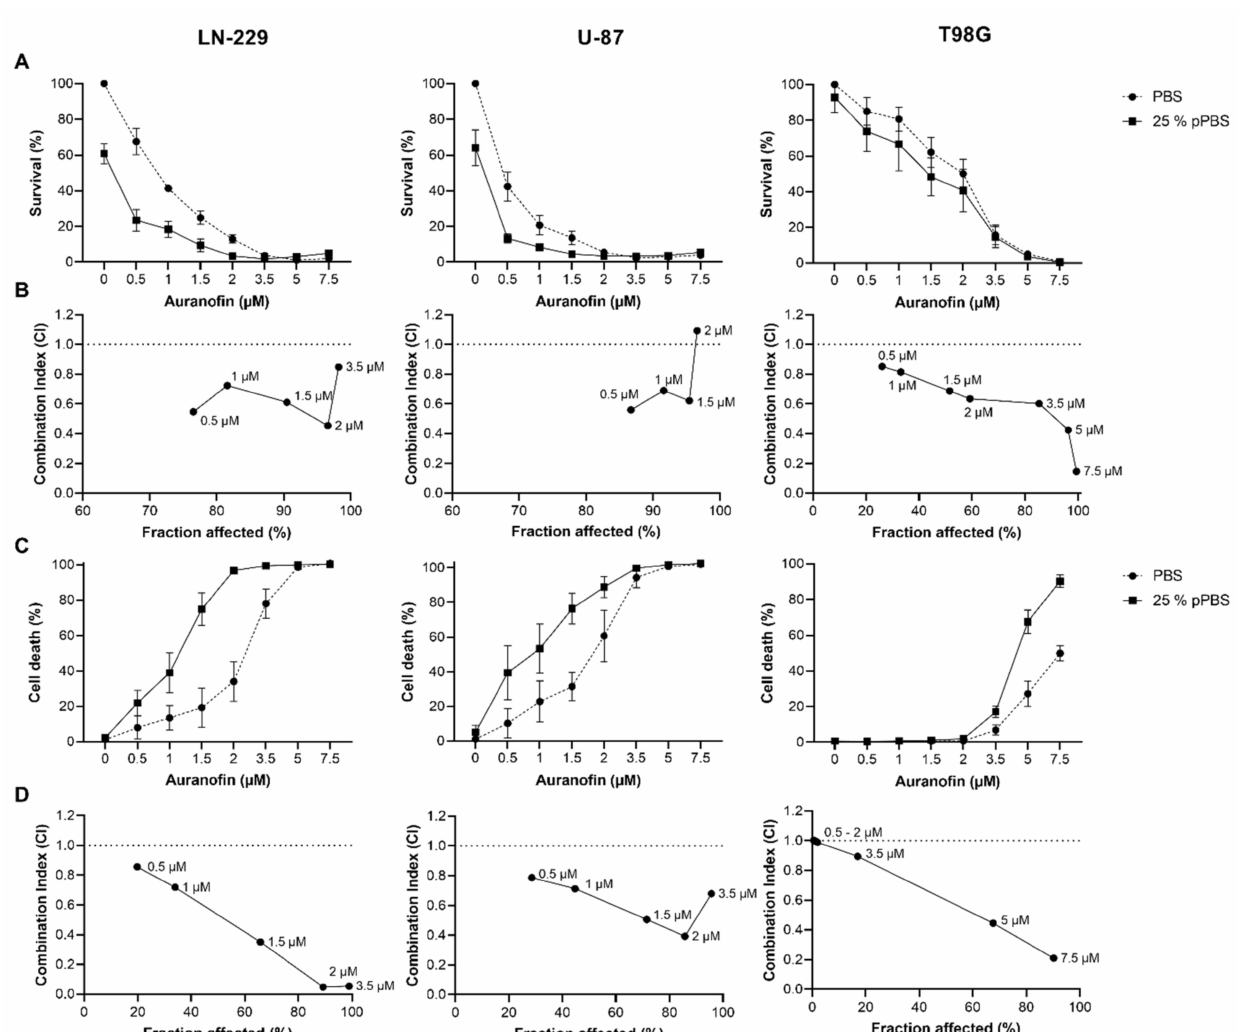
Figure 1. The sequential combination treatment of AF and pPBS induces a synergistic response in cell survival and cell death of GBM cell lines. ( A ) Dose–response survival curves after 72 h of AF (0–7.5 µ M) monotherapy and treatment in combination with 25% pPBS. ( B ) The corresponding combination indexes (CI) for each AF concentration based on survival. ( C ) Dose–response curves of the cytotoxic effect after 72 h of AF (0–7.5 µ M) monotherapy and treatment in combination with 25% pPBS. ( D ) The corresponding combination indexes for each AF concentration based on cytotoxicity. CI > 1 indicates an antagonistic effect, CI = 1 an additive effect and CI < 1 a synergistic effect. Fraction affected indicates the fraction of cells (in percentages) affected by AF. The supporting data and statistics for this figure can be found in Table 1. Graphs represent mean ± SEM of ≥ 3 independent